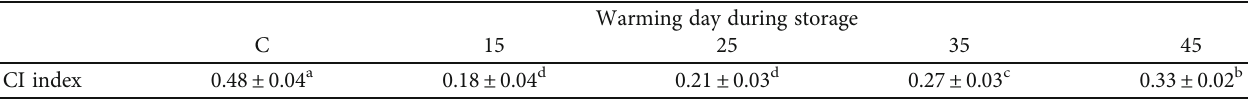
Table 3: Di ff erences in chilling injury index between control and intermittently warmed fruit after 70 days of cold storage and additional 3 days shelf life at 20 °